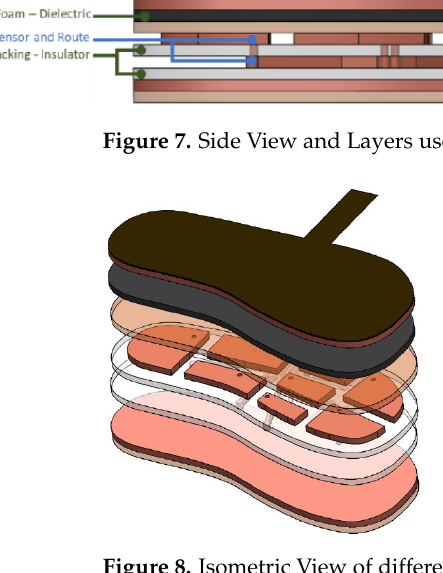
Figure 8. Isometric View of different sensor layers.